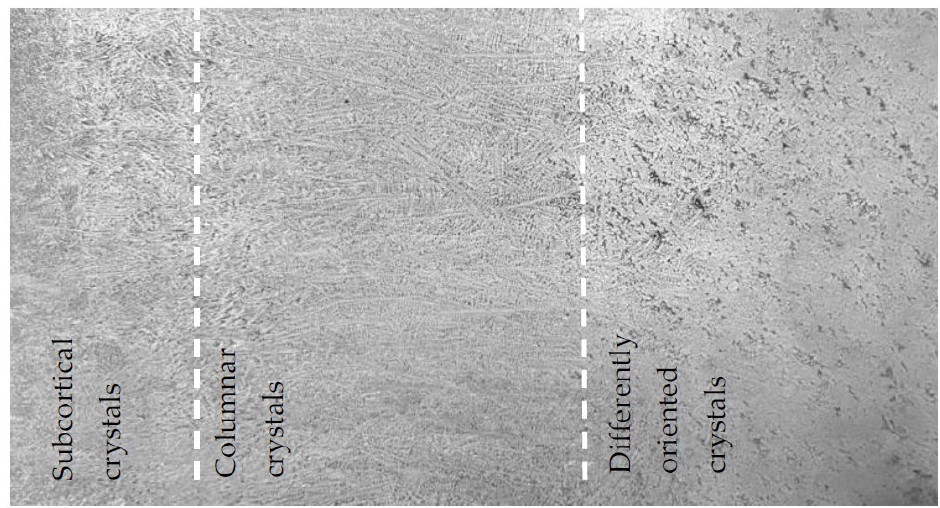
Figure 6. Continuous casting billet (CCB) template 100 mm long after macroetching with hydrochloric acid (HCl).